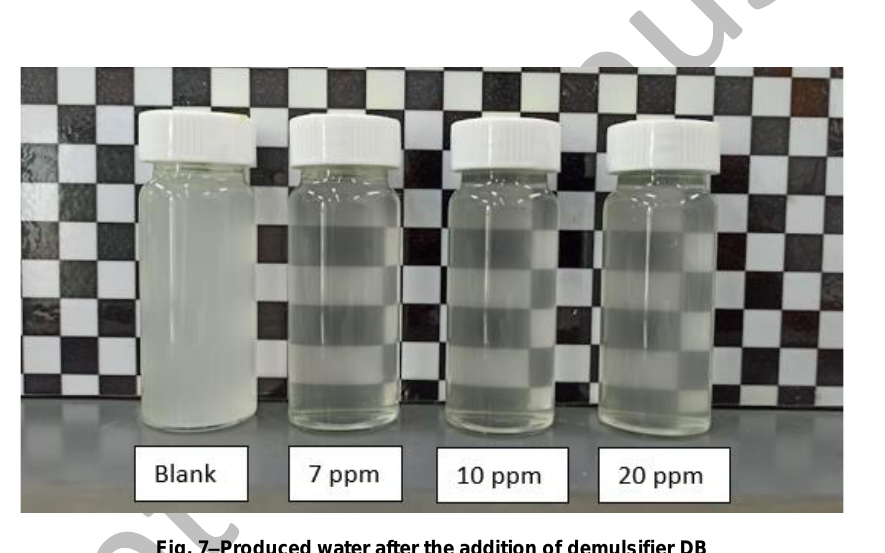
Fig. 7–Produced water after the addition of demulsifier